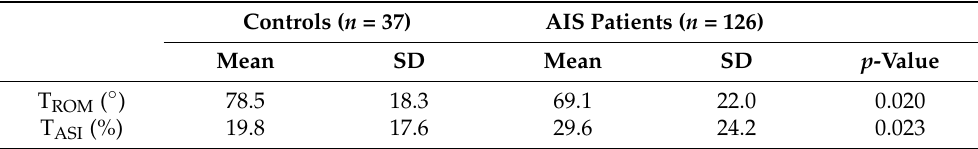
Table 2. T ROM and T ASI of AIS patients and controls and independent sample t -test p